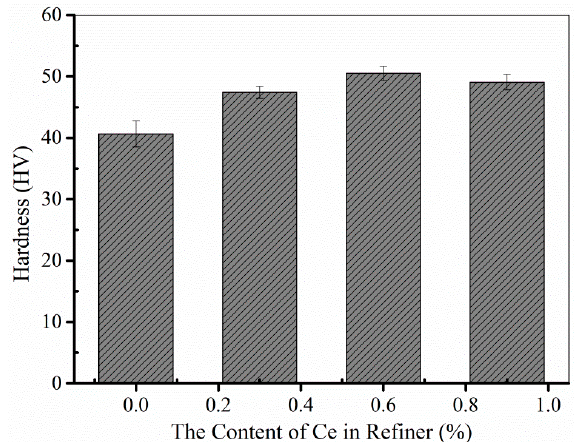
Figure 10. Vickers micro-hardness of Al–7Si-(Al–5Ti- x (Mg–30%Ce)).